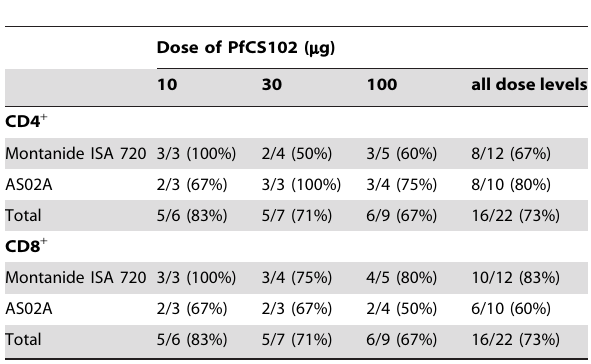
Table 4. Analysis of IFN- c producing CD4 + and CD8 + T cell responses based on the dose of peptide per injection or the adjuvant used.